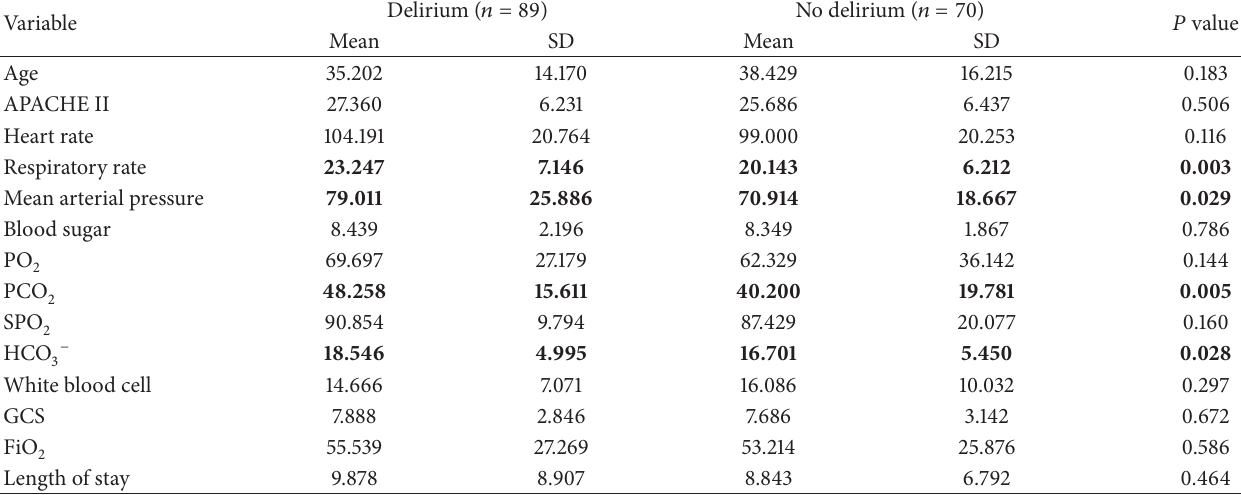
Table 4: Clinical characteristics of patients with and without delirium by univariate